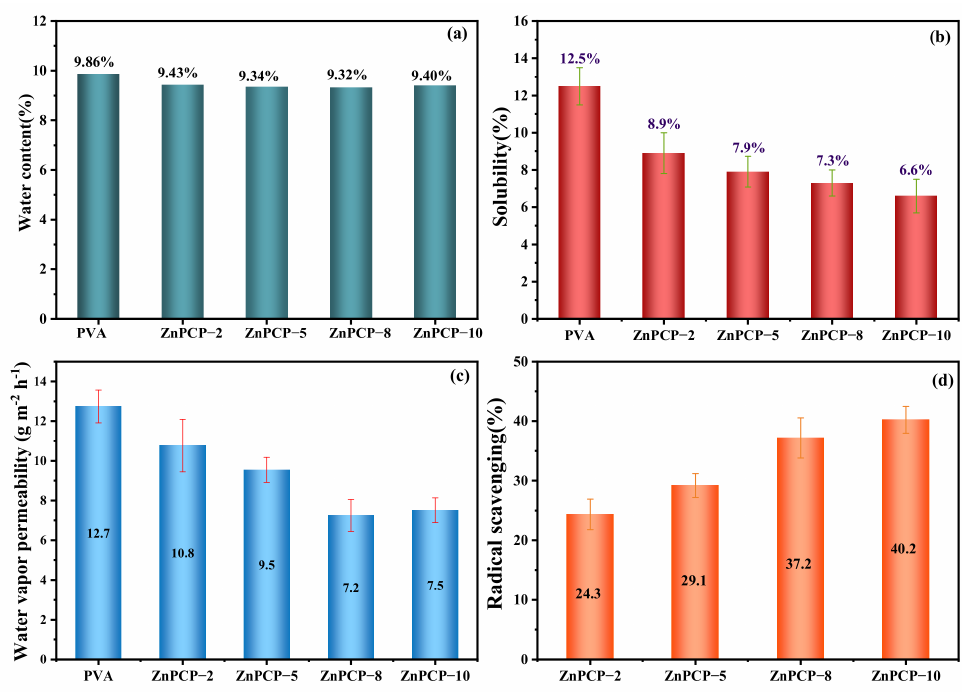
Figure 5. ( a ) The water contents, ( b ) water solubility and ( c ) water vapor permeability of PVA and ZnPCP films, together with ( d ) the antioxidant activity of